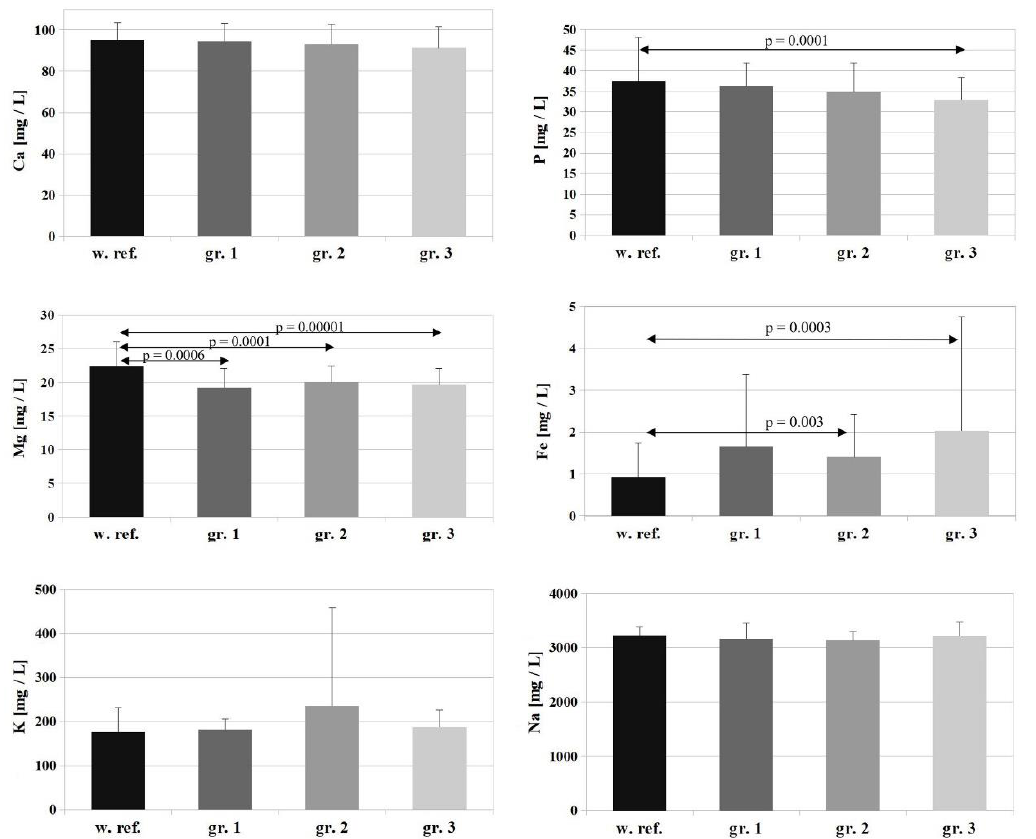
Figure 1. Comparison of reference values for Ca, P, Mg, Fe, K and Na and their concentrations in the serum of patients on the first day of hospitalization. w.ref. – reference value; gr –